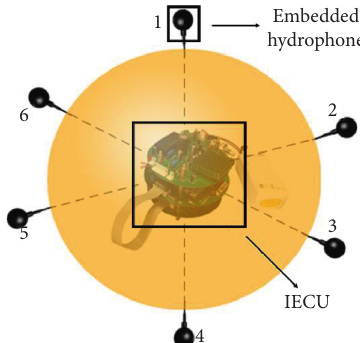
Figure 2: Components of an intelligent submerged buoy (ISB).